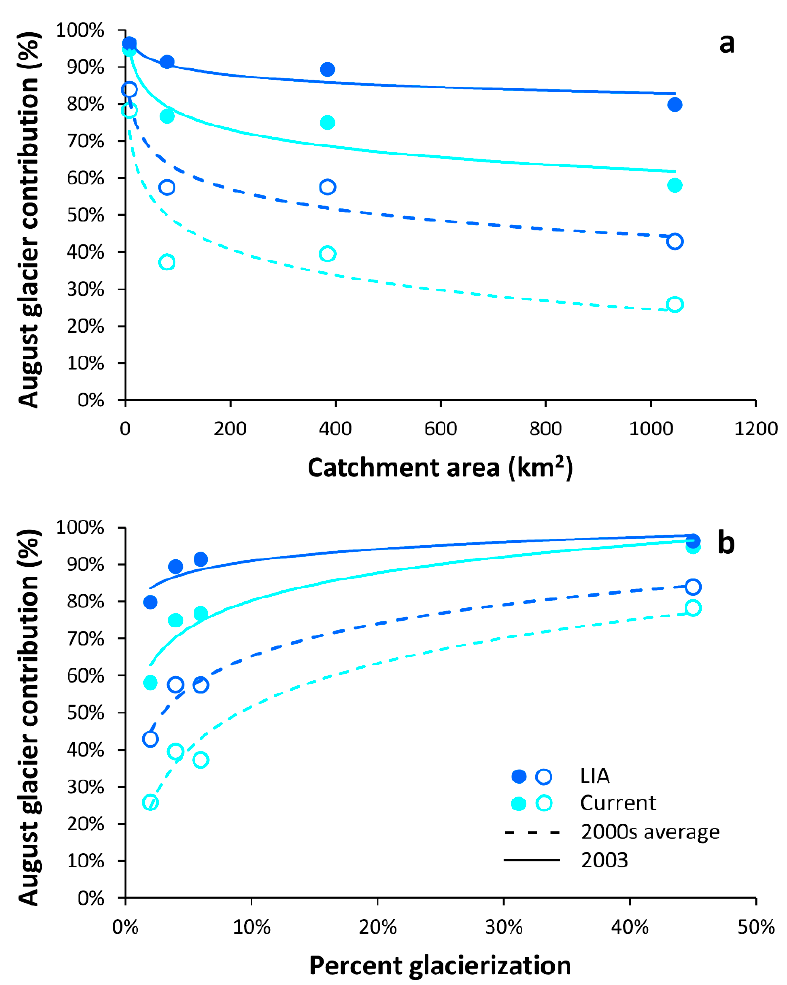
Figure 10. Percent glacier contribution to August runoff vs. ( a ) catchment area, and ( b ) percent glacierization. Average contribution in the 2000s (decade from 2003 to 2012) is compared with contribution in 2003. Tentative logarithmic regressions lines are applied to each series. Table 5. Unit discharge (m 3 s − 1 km − 2 ) in August during the decade from 2003 to 2012, and in 2003. Value in bold indicate 2003 unit discharge larger than average 2003–2012 unit discharge. Residual damping effect (RDE) for the Current glaciers are shown in brackets.